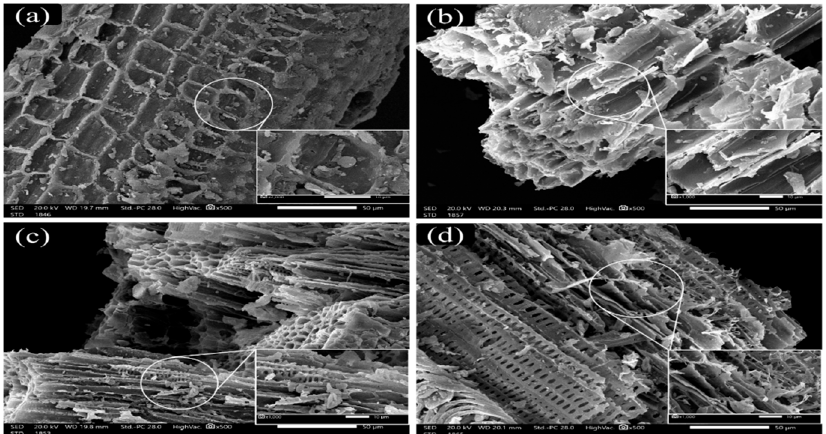
Figure 7. SEM images of sesame stalk feedstock (SF) and its different biochar types produced at 300 ° C for 3 hrs: ( a ) sesame stalk feedstock (SF); ( b ) SB-1 biochar formed around the inner sidewalls of the internal chamber of the parabolic dish collector); ( c ) SB-2 biochar formed on the upper part of the internal chamber; and ( d ) SB-3 biochar of conventional method (muffle production).